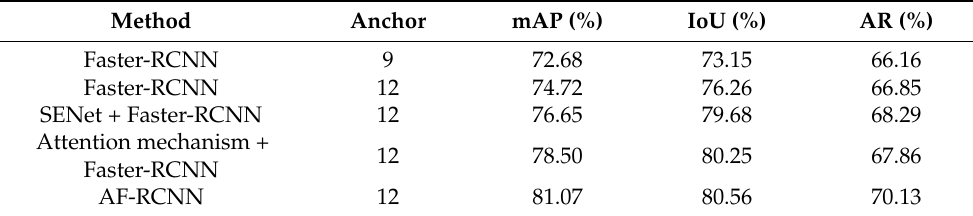
Table 2. Detection results of ablation experiment.